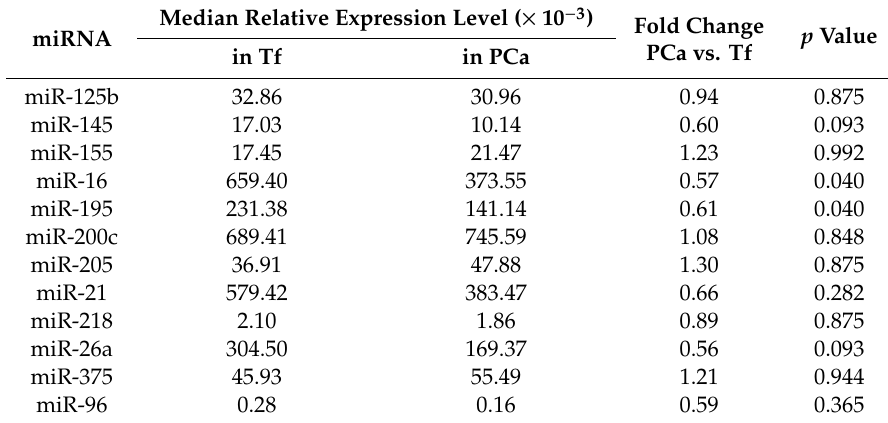
Table 2. Relative expression levels of miRNAs and respective fold changes in urinary sediments from Tf and PCa